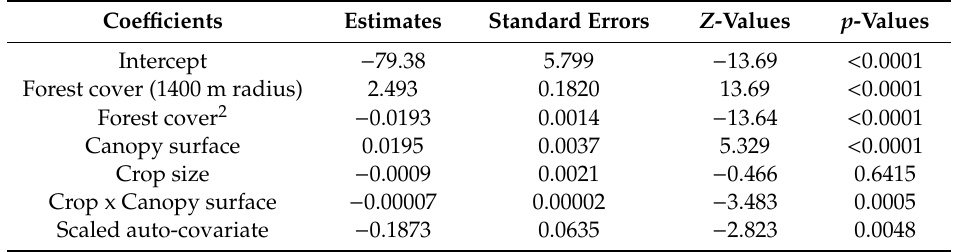
Table 2. Selected auto-covariate logistic regression models of seed removal rate with Efron’s pseudo R-squared and likelihood ratio tests. Inga vera , sample size = 15. Coe ffi cients Estimates Standard Errors Z -Values p -Values